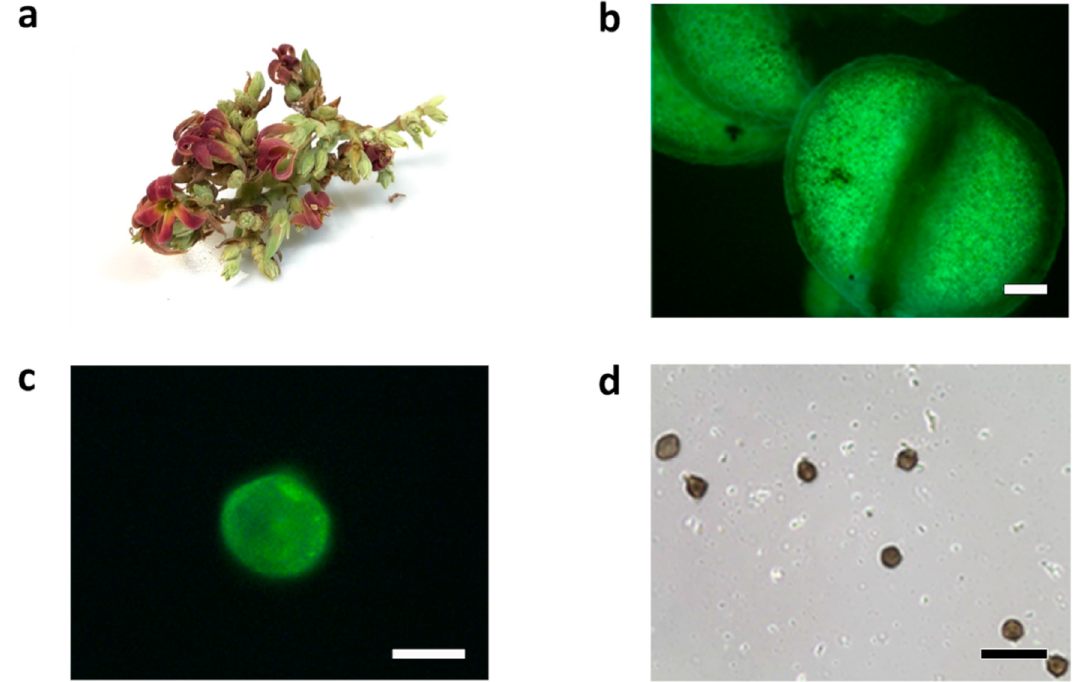
Figure 1. Cashew flowers and pollen particles. ( a ) a cashew flower, ( b ) autofluorescent image of anthers from a cashew flower (scale bar represents 100 µm), ( c ) autofluorescent image of pollen grains from a cashew flower (scale bar represents 20 µm), ( d ) pollen grain from a cashew flower used for measurement (scale bar represents 100 µm).